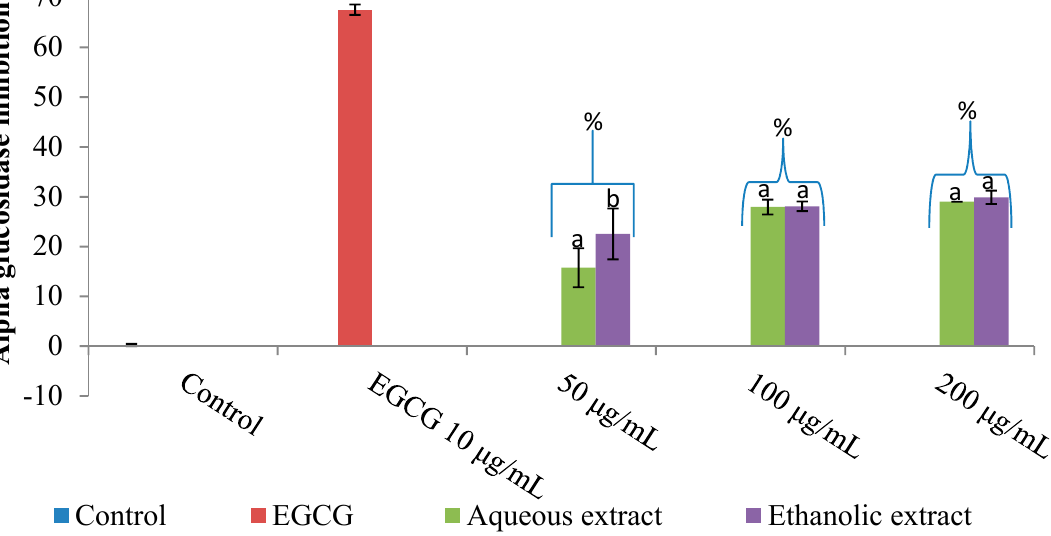
Figure 2. Bar chart showing the inhibition of α‐ glucosidase by aqueous and ethanolic extracts of Vernonia mespilifolia . The values in the bar chart are expressed as mean ( α‐ glucosidase inhibition) ± SD (n = 5). Mean separation was done by LSD ( p < 0.05). Sets of bars (the same concentration) with different alphabets are significantly different; p < 0.05. % Less than the EGCG (epigallocatechin gallate) (positive control).